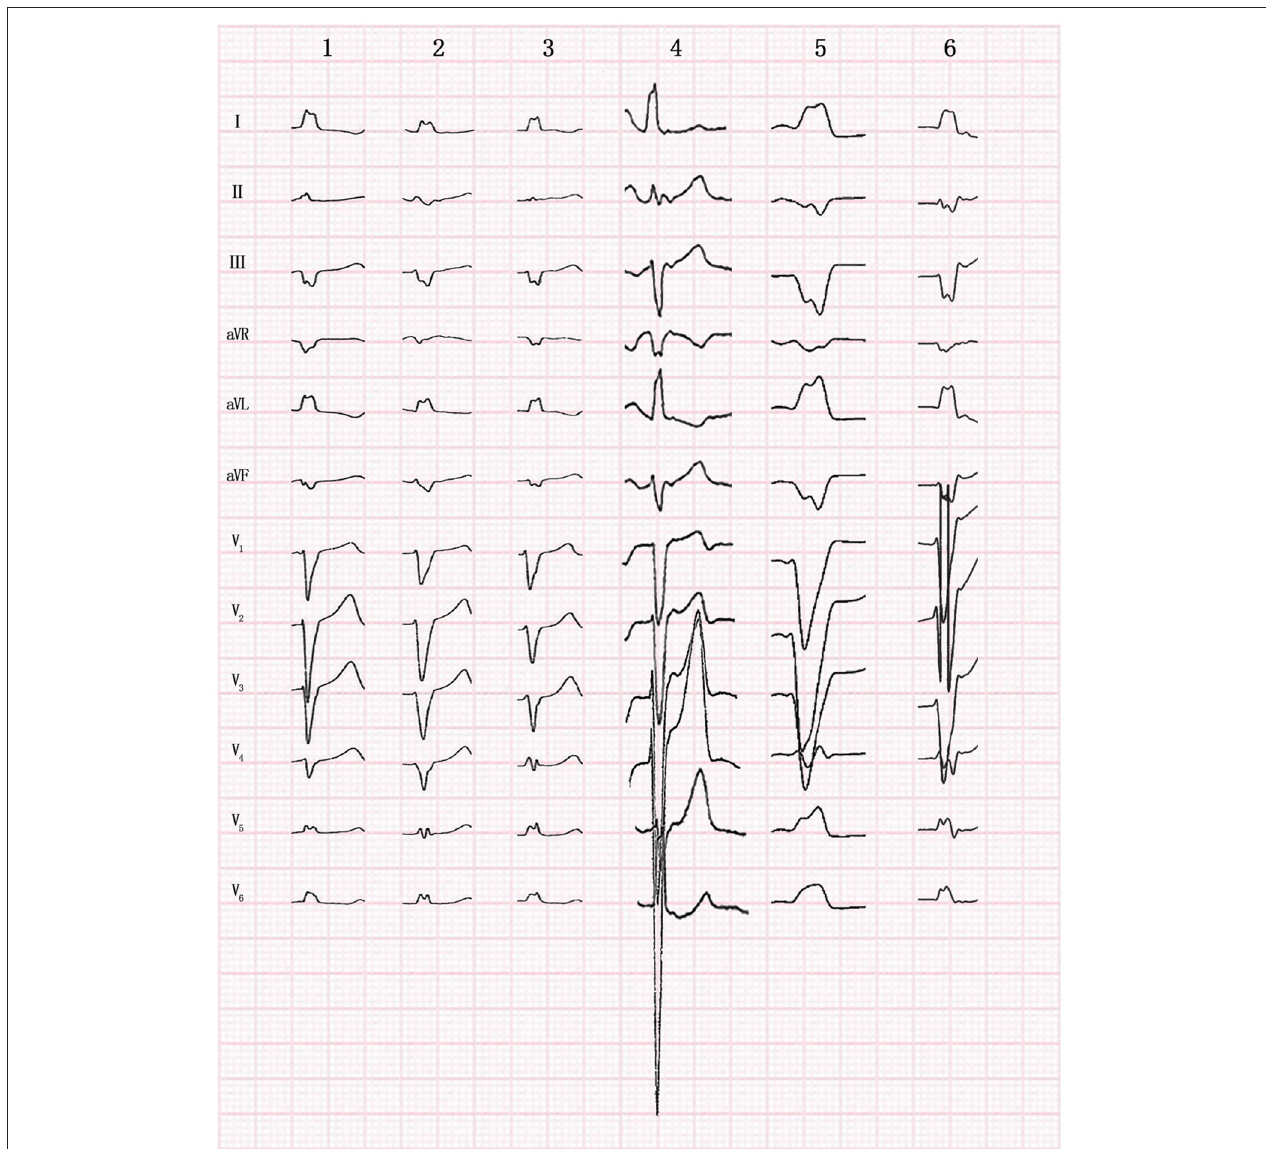
FIGURE 3 | Twelve-lead morphology of premature ventricular contraction originating from the moderator band in 6 patients.